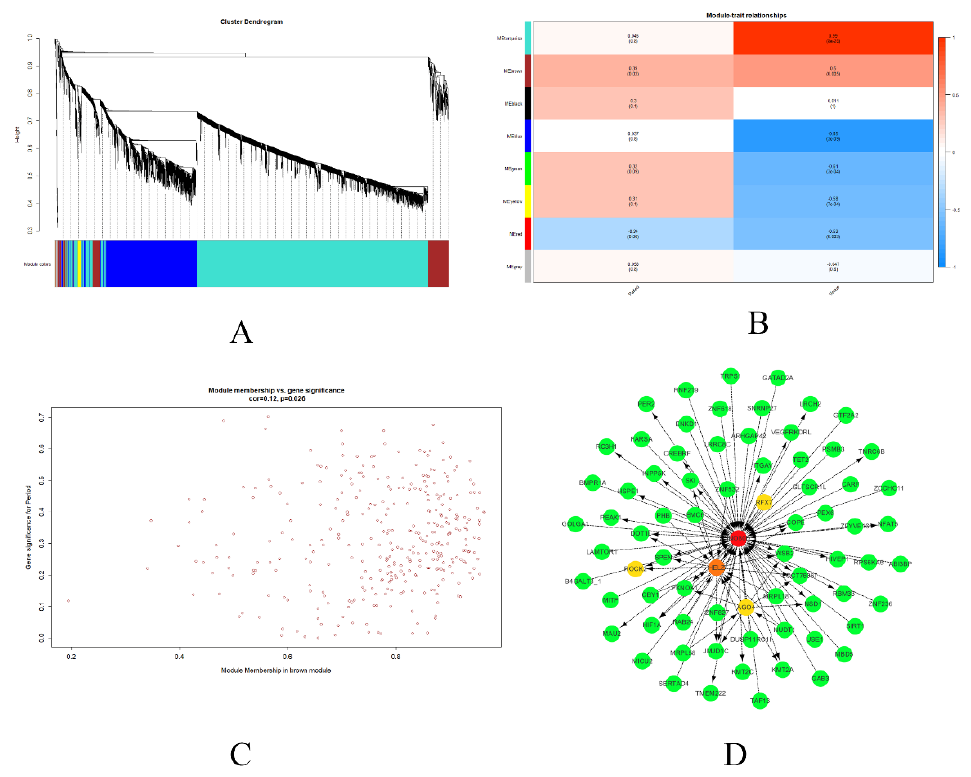
Figure 5. The data of all genes expressed in the hypothalamus and ovary in 5 periods were analyzed by WGCNA. Gene dendrogram obtained based on a dissimilarity measure (1-TOM) ( A ). Relationships of module eigengenes vs. period and tissue ( B ). Scatterplots of gene significance (GS) vs. module membership (MM) in the brown module ( C ). Visualization of modules: the hub genes in the modules are highlighted in red and yellow ( D ).